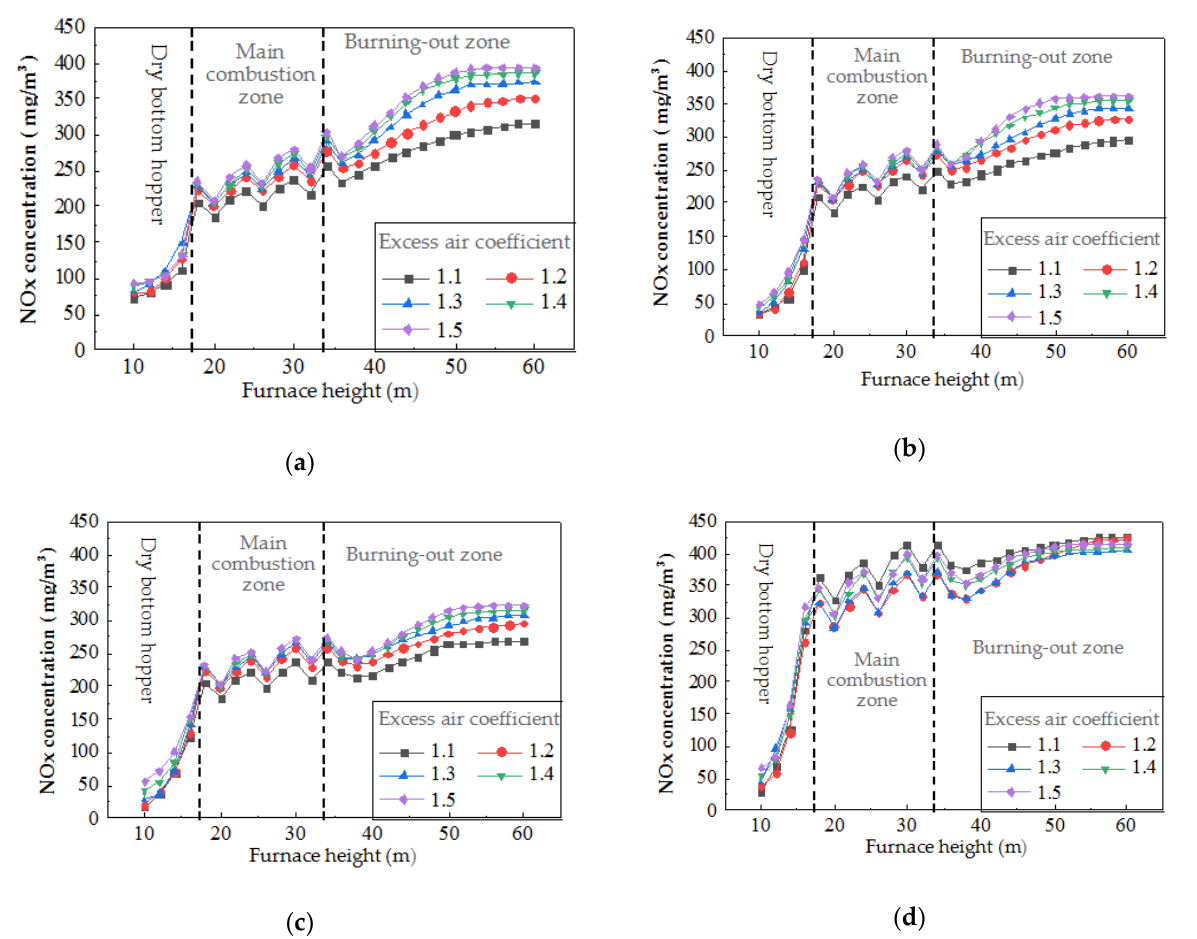
Figure 11. Variation in NOx concentration along the furnace height under different excess air coefficient: ( a ) Variation in NOx concentration along furnace height under different excess air coefficient and 600 MW boiler load; ( b ) Variation in NOx concentration along the furnace height under different excess air coefficient and 500 MW boiler load; ( c ) Variation in NOx concentration along the furnace height under different excess air coefficient and 400 MW boiler load; ( d ) Variation in NOx concentration along the furnace height under different excess air coefficient and 250 MW boiler load.